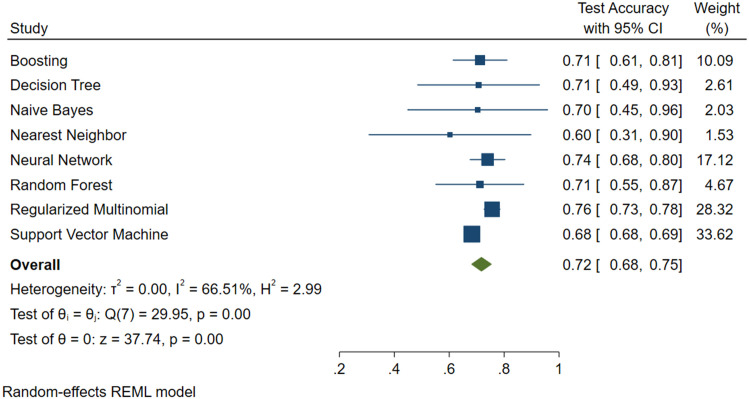
Machine learning applied to NAFLD diagnosis.Forest Plot for the AVI plus Glucose plus GGT plus Age plus Sex Predictive Model.